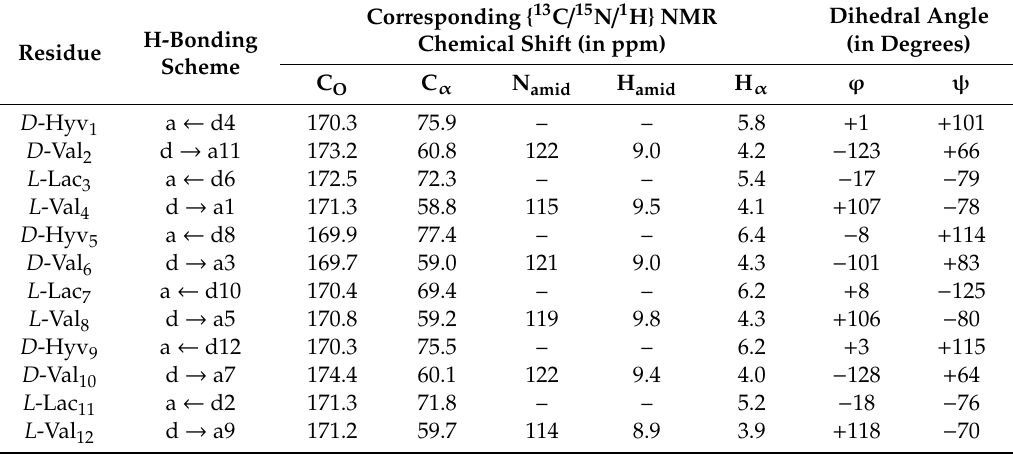
Table 3. The PW PBE structural and spectral parameters of the “symmetric” crystalline phase of VLM.